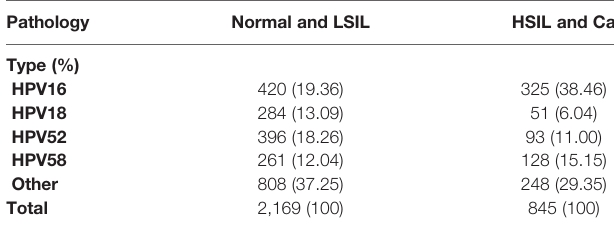
TABLE 2 | Distribution of HPV subtypes in different cervical